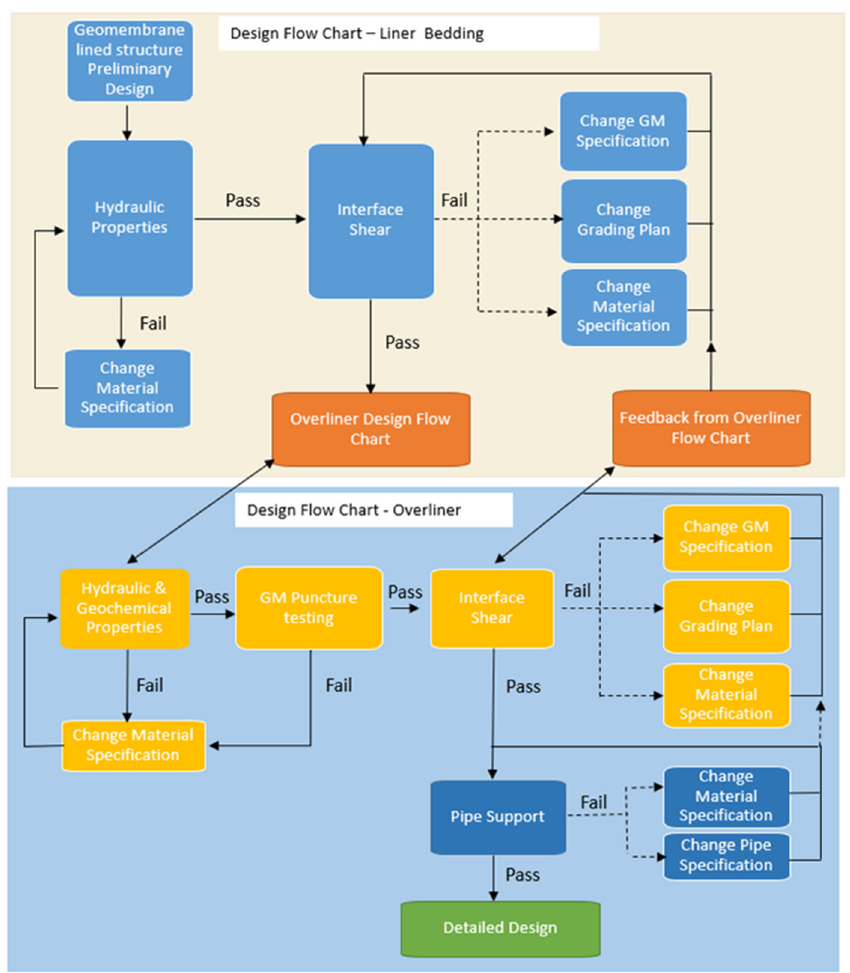
Figure 8. Logic chart for the design of liner bedding and overliner for a basal liner system (GM = geomembrane) modified from [5].